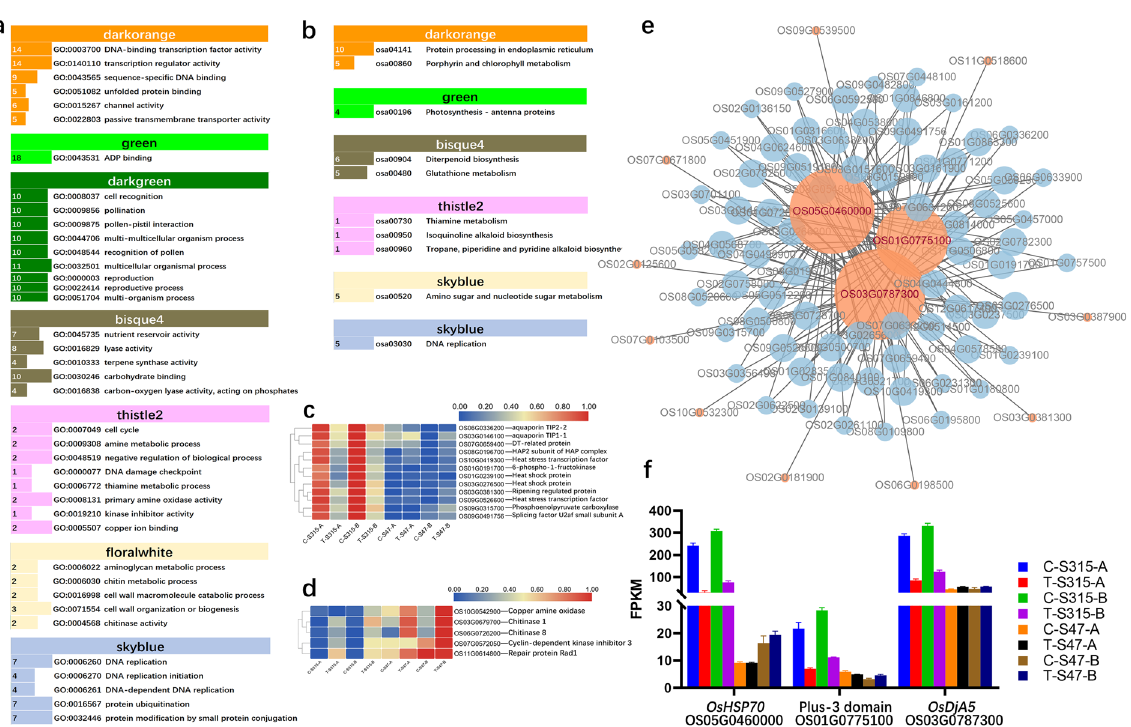
Figure 5. The modules relevant to different rice varieties. ( a,b ) the Gene Ontology biological processes (GO-BP) and KEGG pathways associated with modules associated with high Cd accumulative trait. The number ahead of the items indicates the gene number. ( c,d ) the reads number of several DEGs in the high Cd accumulation positive and negative modules, respectively. e, gene interaction network analysis results of DEGs negatively regulated by Cd stress in S315. f, the expression profiles of key regulators in the interaction network. The bigger the node, the greater the number of connections it has. Nodes with different colors are with different number of